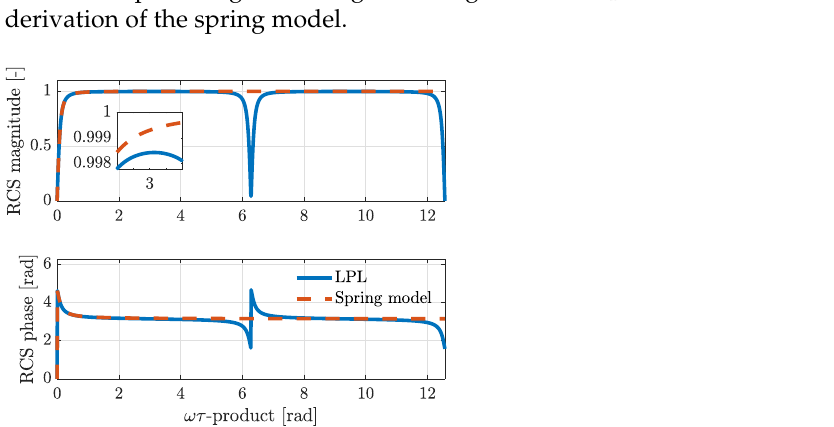
Figure 2. Reflection coefficient spectrum as a function of the ωτ -product, with reflection coefficients of R 1 = − R 2 = −